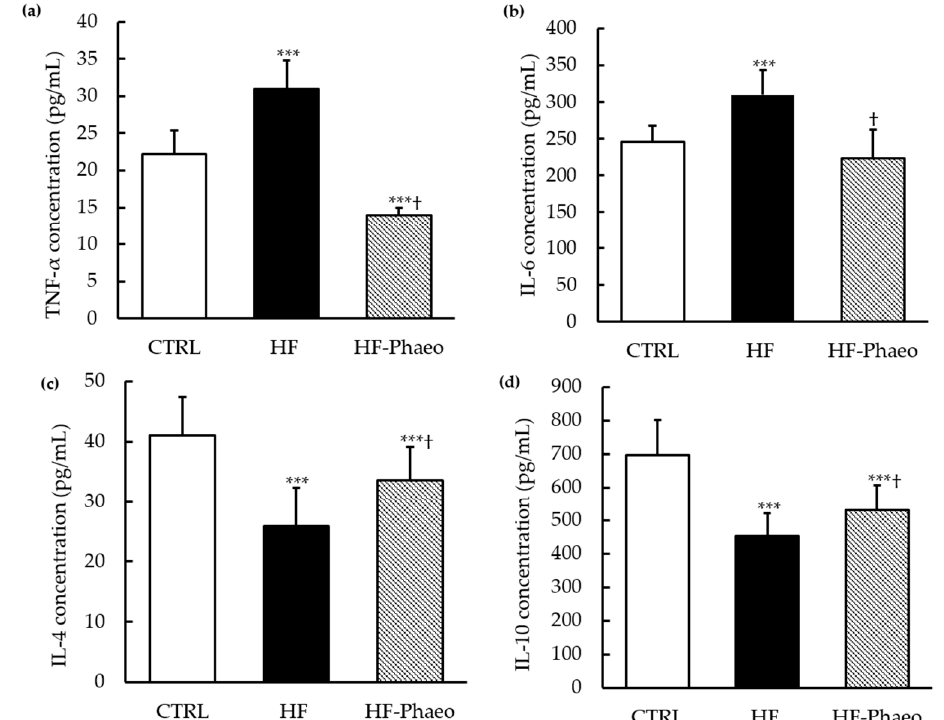
Figure 2. E ff ects of P. tricornutum supplementation on inflammatory biomarkers. The plasma